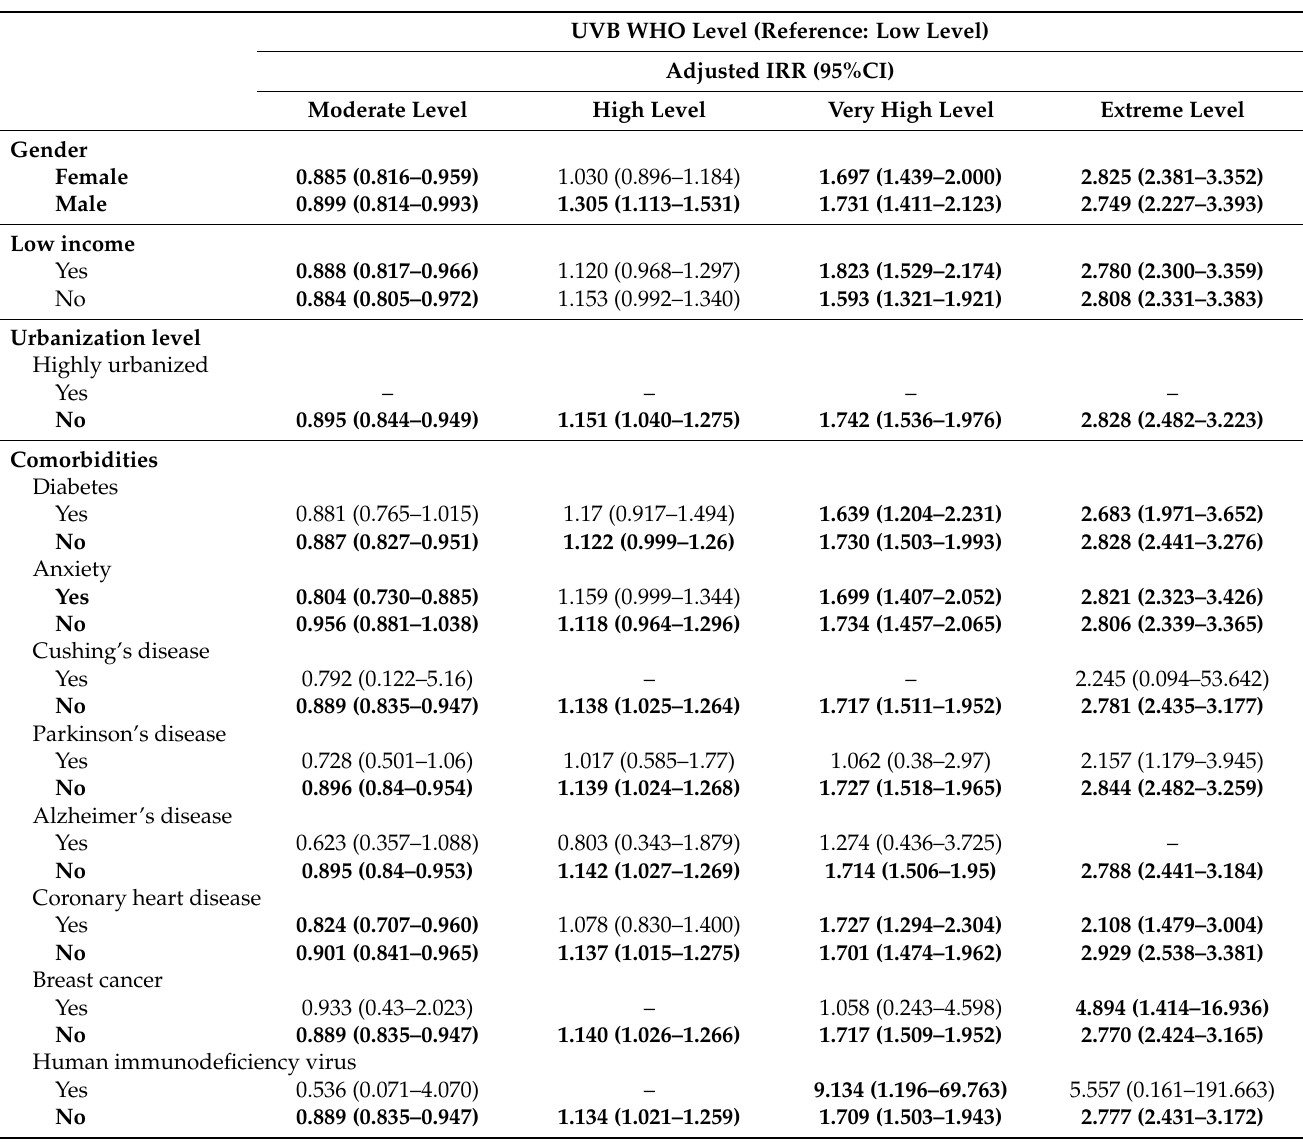
Table 4. Subgroups Poisson regression analysis of Ultraviolet radiation b (UVB) and